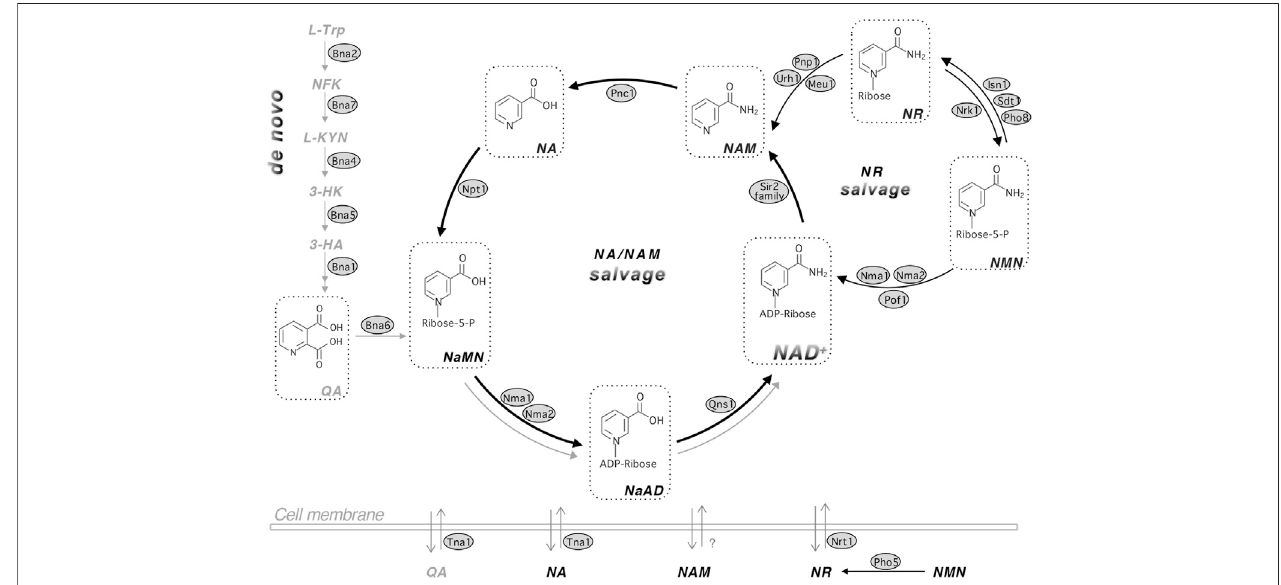
FIGURE 1 | The NAD + biosynthetic pathways in yeast Saccharomyces cerevisiae . Budding yeast maintains the NAD + pool by three major pathways: de novo synthesis ( left panel ), NA/NAM salvage ( center circle ) and NR salvage ( right circle ). NAD + can be made by salvaging precursors such as NA, NAM and NR or by de novo synthesis from L-TRP . Yeast cells also release and re-uptake these precursors. The de novo NAD + synthesis ( left panel ) is mediated by Bna proteins (Bna2,7,4,5,1) leading to the production ofNaMN. This pathway is inhibited by Hst1 when NAD + is abundant and therefore is shown in gray color. The NA/NAM salvage pathway ( center circle ) also produces NaMN, which is then converted to NaAD and NAD + by Nma1/2 and Qns1, respectively. NAD + biosynthesis from the NA/NAM salvage and de novo pathwaysconverges at the formationofNaMN.The NA/NAM salvage pathway ishighlighted with bold black arrows because mostyeastgrowth media contain abundantNA.Inmammals,NAMisconvertedtoNMNbyNAMphosphoribosyltransferase,NAMPTorconverted toNAbymicrobialnicotimidaseinthegut.NRsalvage ( right circle ) connects to the NA/NAM salvage pathway by Urh1, Pnp1 and Meu1. NR turns into NMN by Nrk1, which is then converted to NAD + by Nma1, Nma2 and Pof1. Forsimplicity, NaR (nicotinic acidriboside) and NRH (reduced NR)salvage pathways,which overlap with NRsalvage, are notshown in this fi gure.Abbreviationsof NAD + intermediatesareshowninbold anditalicized. NA ,nicotinicacid. NAM ,nicotinamide. NR ,nicotinamideriboside. QA ,quinolinicacid. L-TRP , L -tryptophan. NFK , N-formylkynurenine. L-KYN , L -kynurenine. 3-HK , 3-hydroxykynurenine. 3-HA , 3-hydroxyanthranilic acid. NaMN , nicotinic acid mononucleotide. NaAD , deamido- NAD + . NMN , nicotinamide mononucleotide. Abbreviations of protein names are shown in shaded ovals. Bna2, tryptophan 2,3-dioxygenase. Bna7, kynurenine formamidase. Bna4, kynurenine 3-monooxygenase. Bna5, kynureninase. Bna1, 3-hydroxyanthranilate 3,4-dioxygenase. Bna6, quinolinic acid phosphoribosyl transferase.Nma1/2,NaMN/NMNadenylyltransferase (NMNAT).Qns1,glutamine-dependentNAD + synthetase. Npt1,nicotinic acidphosphoribosyltransferase.Pnc1, nicotinamide deamidase. Sir2 family, NAD + -dependent protein deacetylases. Urh1, Pnp1 and Meu1, nucleosidases. Nrk1, NR kinase. Isn1 and Sdt1, nucelotidases. Pho8 and Pho5, phosphatases. Pof1, NMN adenylyltransferase (NMNAT). Tna1, NA and QA transporter. Nrt1, NR